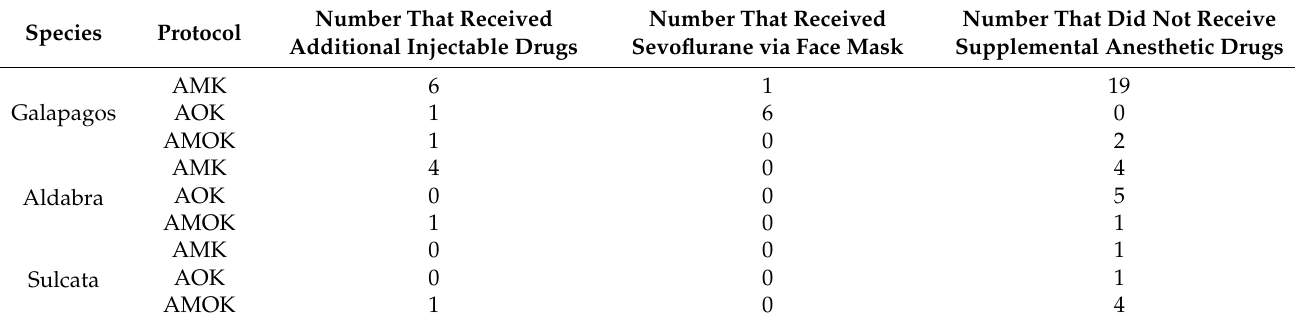
Table 3. Summary of additional premedication or anesthetic agents administered to each species by the most commonly used drug class combinations. The three most common drug class combinations were an α 2 -adrenergic agonist combined with a µ -opioid and ketamine (AOK), an α 2 -adrenergic agonist combined with midazolam and ketamine (AMK), and an α µ -opioid, midazolam, and ketamine (AMOK). 2 -adrenergic agonist combined with a